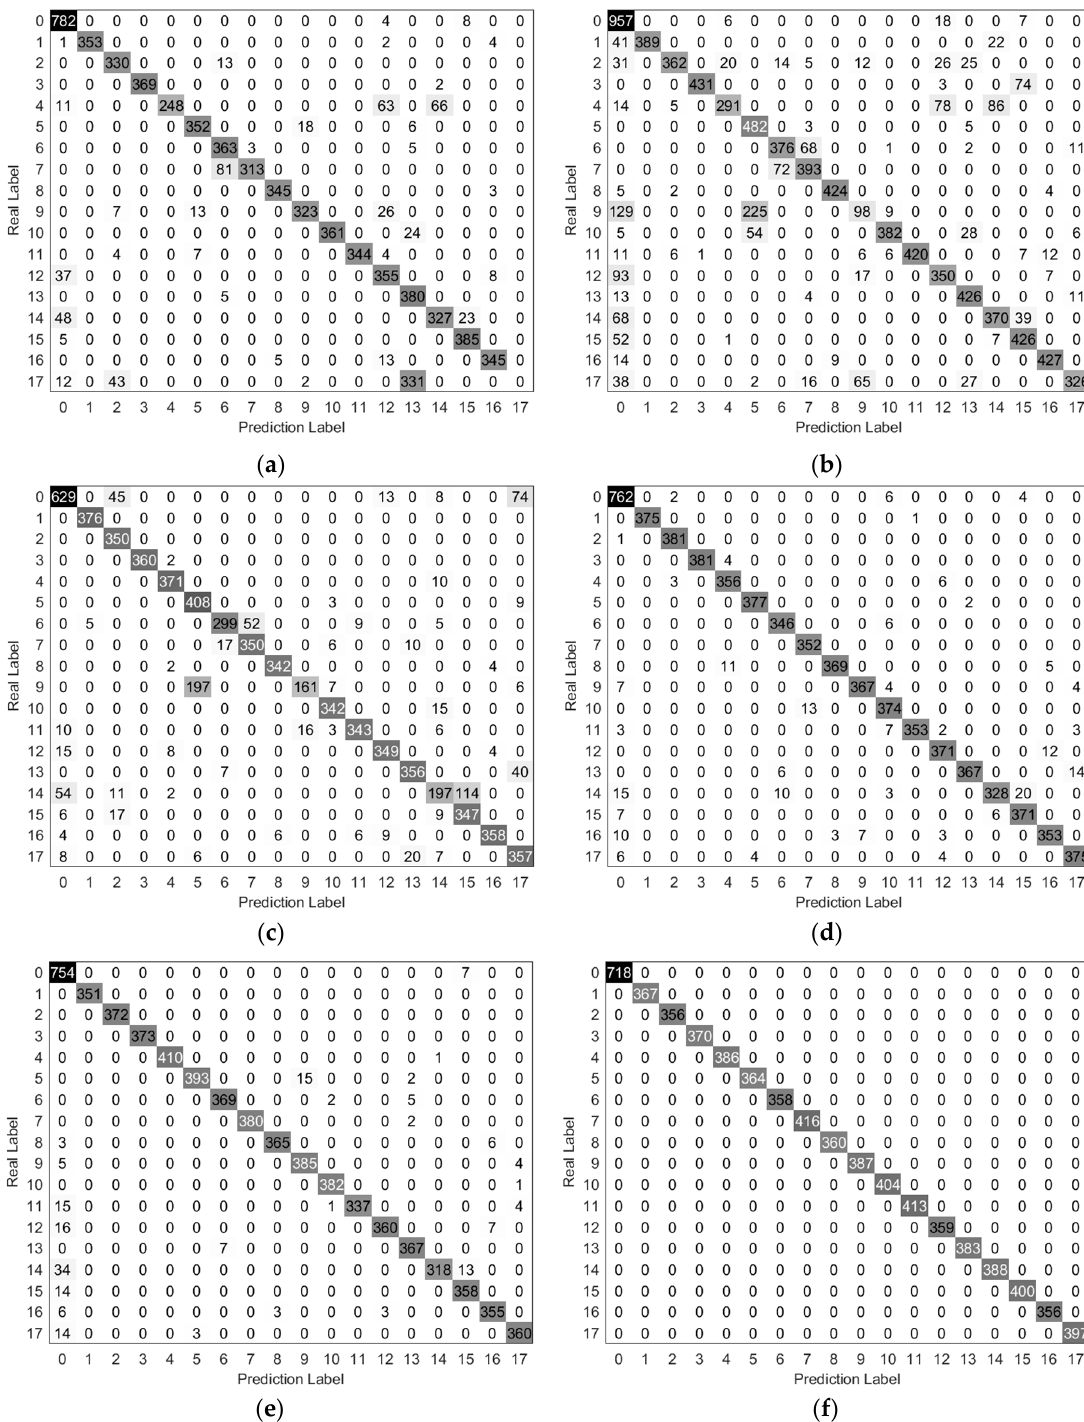
Figure 14. Training loss value and accuracy of LSTM algorithm.